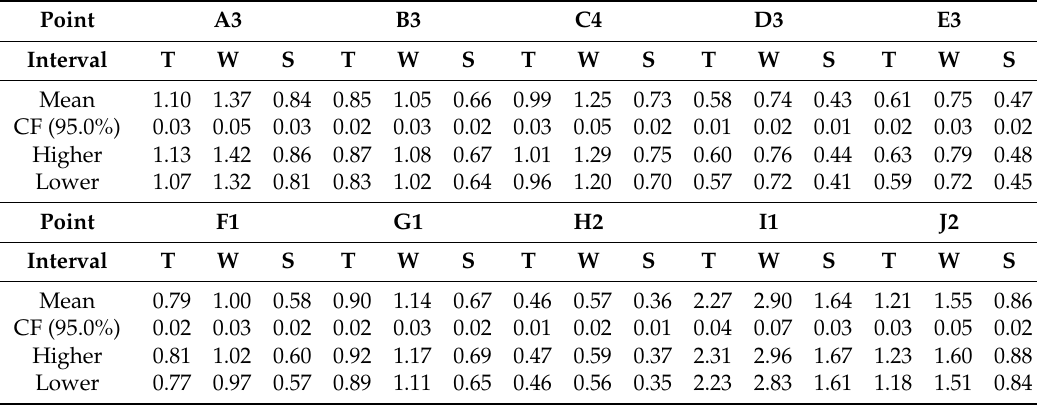
Table 5. Linear trend confidence levels of the average significant wave height, computed for 10 reference points (one of each zone) considered as the most representative. Results corresponding to the 35-year time interval 1983–2017. CF represents the 95.0% confidence